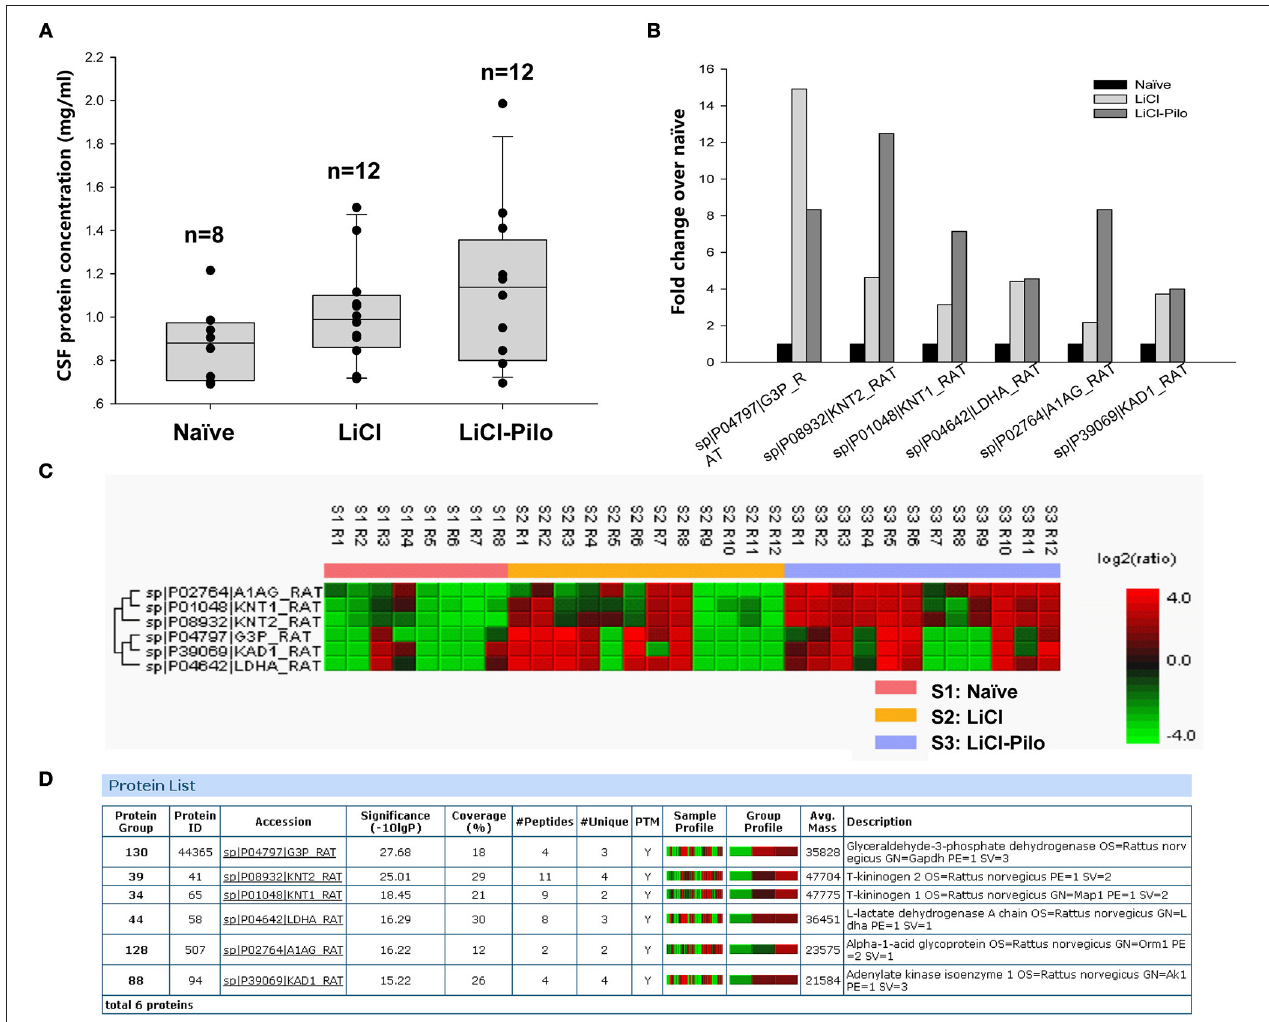
FIGURE 1 | Proteomic analysis of CSF in SD rats 5 days after SE. (A) The concentration of total proteins in the Naïve, LiCl and LiCl-Pilo groups. (B) The fold changes in proteins differentially expressed in the CSF of the three groups. The protein in the naïve group was normalized to 1.0. (C,D) Results of proteomics analysis.